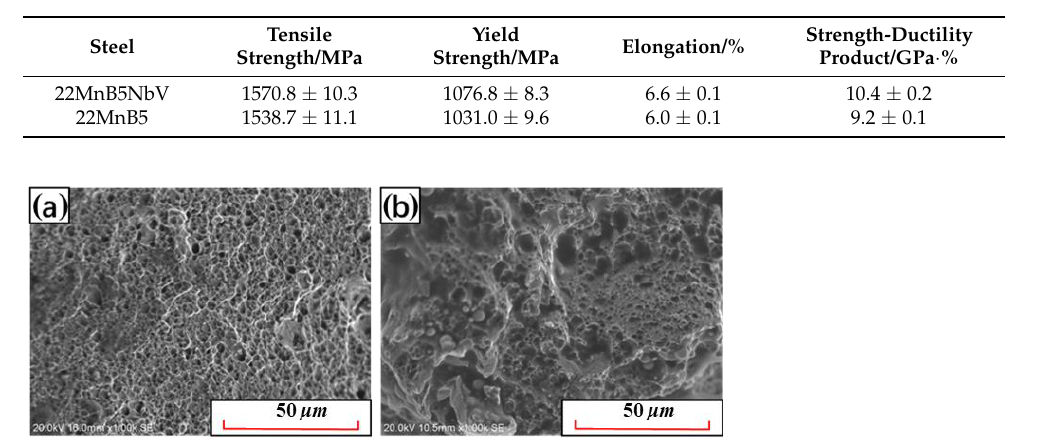
Figure 16. Comparison of fracture surfaces between 22MnB5NbV and 22MnB5 steel: ( a ) 22MnB5NbV, ( b ) 22MnB5.